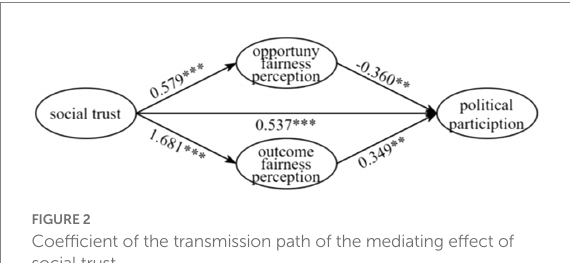
FIGURE 3 Coefficient of the transmission path of the mediating effect of social